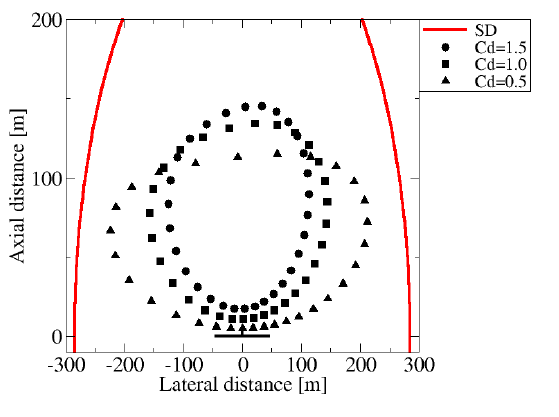
Figure 7. Impact positions for different values of the drag